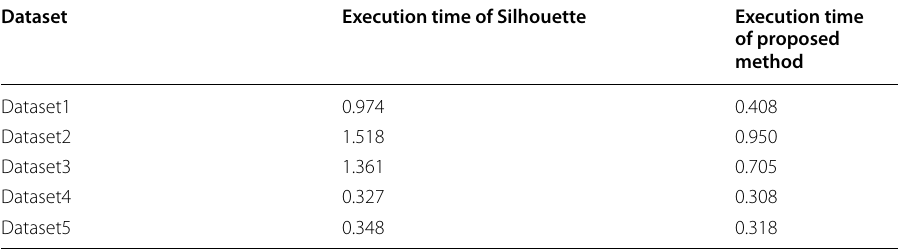
Table 3 The execution time of two methods based on different datasets (unit: s)